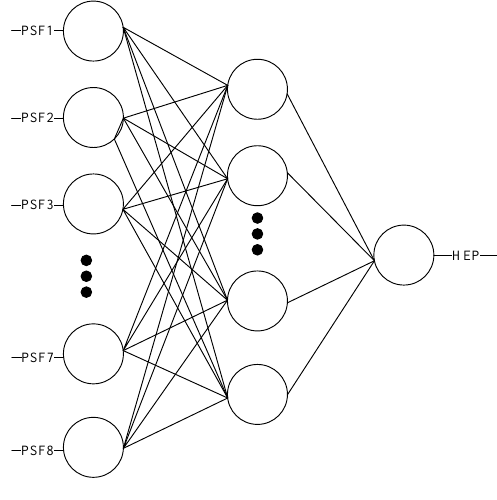
Fig. 3. The ANN layers